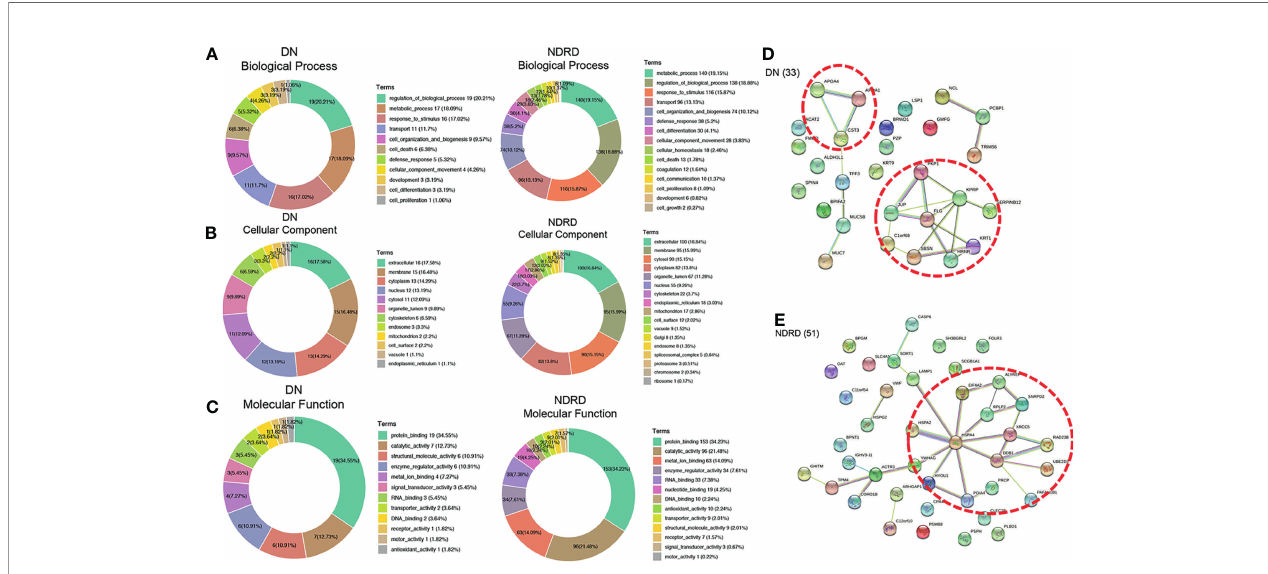
FIGURE 6 | Bioinformatics analysis of differential glycoproteins isolated from DN and NDRD. Differential proteins were analysed using Gene Ontology (GO). DN, diabetic nephropathy; NDRD, non-diabetic renal disease. (A) Pie charts showing the biological processes of differential proteins between DN and NDRD. (B) Pie charts showing the cellular component of differential proteins between DN and NDRD. (C) Pie charts showing the molecular function of differential proteins between DN and NDRD. Next to their position are shown the associated term names on the chart. (D) STRING 9.0 was used to generalise and visualise the protein interaction network of differential proteins from DN. (E) STRING 9.0 was used to generalise and visualise the protein interaction network of differential proteins from NDRD. Line thickness represents the strength of the association between molecules. Networks with three or more protein interactions are shown. The con fi dence (score) required for protein association is high. The selected protein core complexes with important functions and proteins involved in the same biochemical reaction are marked with a red dotted